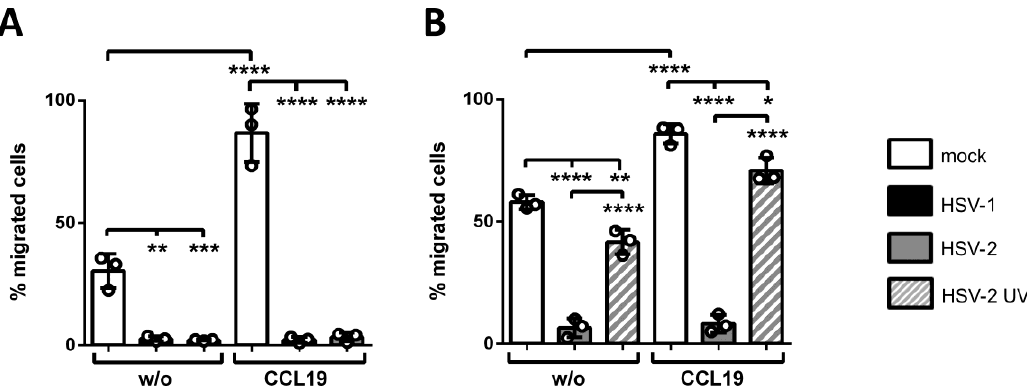
Figure 4. HSV-2 inhibits mDC transwell migration toward a CCL19 chemokine-gradient early upon infection. ( A ) Mature DCs were mock-, HSV-1- (MOI of 2) or HSV-2-infected (MOI of 5) and harvested 24 hpi. ( B ) Mature DCs were mock-, HSV-2- (MOI of 5), or HSV-2 UV-infected (MOI of 5; 1.200 J / cm 2 ) and harvested 4 hpi. ( A , B ) Cells were subjected to transwell migration assays on fibronectin-coated transwell inserts toward a CCL19 chemokine-gradient (100 ng / mL). Spontaneous migration without addition of chemokines (“w / o”) in the lower wells served as control. Migration capacity was determined after 2 h and percentages of migrated cells were quantified by assessing their β -glucuronidase activity. Mock- (white columns), HSV-1- (black columns), HSV-2 (gray columns), and HSV-2 UV-infected (gray striped columns) mDCs are depicted. The experiments were performed three times with cells from di ff erent healthy donors. Error bars indicate ± SD. Significant changes (**** = p < 0.0001; *** = p < 0.001; ** = p < 0.01; * = p < 0.1) are marked by asterisks.